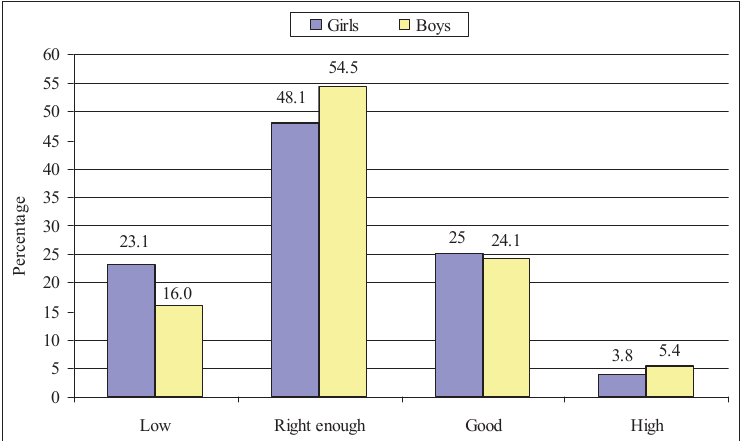
Note. Physical fi tness level was evaluated ac- cording B. Sekita